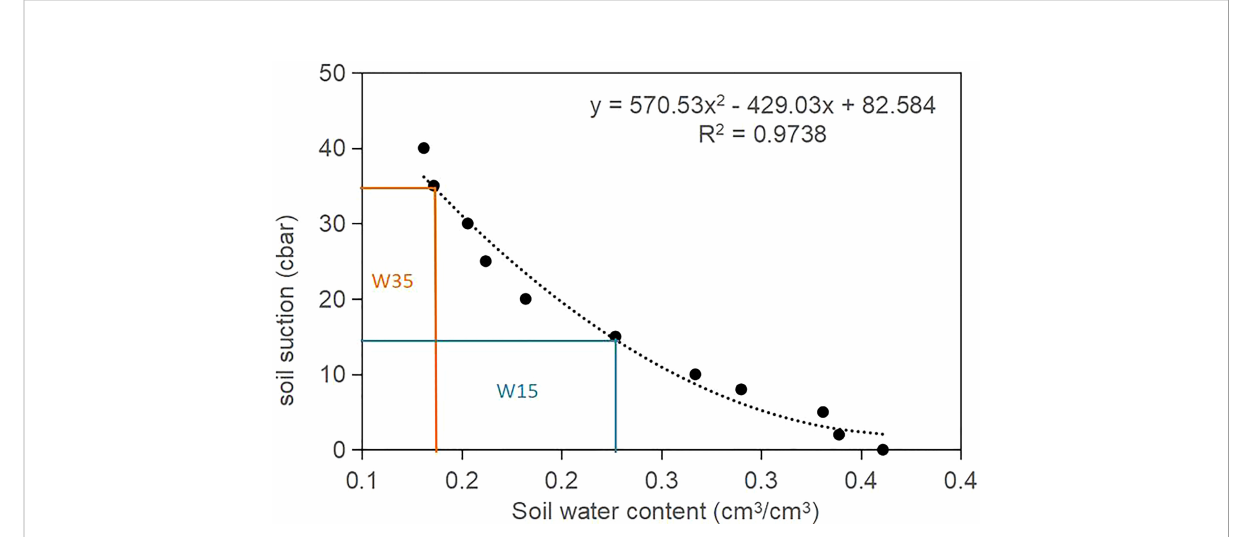
FIGURE 2 The established nonlinear relationship of sol matric potential (expressed as soil suction) and soil water content (SWC) measured at top 20 cm soil layer at the beginning of experiment in